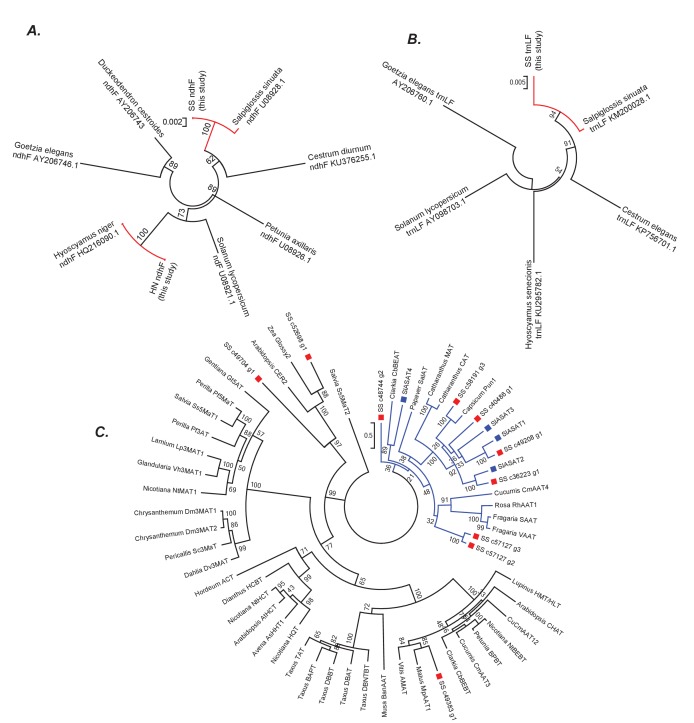
Phylogenetic positions of Salpiglossis, Hyoscyamus and Salpiglossis candidate enzymes.(A,B) Phylogeny based on the ndhF (A) and trnLF spacer (B) sequence amplified from Salpiglossis and Hyoscyamus DNA (this study) and other sequences downloaded from NCBI. Accession numbers of NCBI sequences are noted. Trees were constructed using maximum likelihood approach using the GTRGAMMA model with five rate categories and with 1000 bootstrap replicates. (C) Maximum likelihood tree obtained using PROTGAMMAJTT model in RAxML v8.0.6, with BAHD enzymes described in D'Auria (2006), SlASAT protein sequences (blue squares) and protein sequences of candidate Salpiglossis enzymes (red squares). 1000 bootstraps were specified with bootstopping based on majority rule, and all sites with <70% coverage were discarded. The blue clade represents Clade III as described by D'Auria (2006).